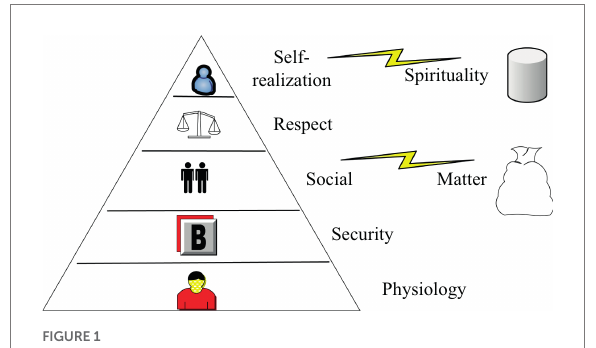
FIGURE 1 Distribution of Maslow’s hierarchical model of